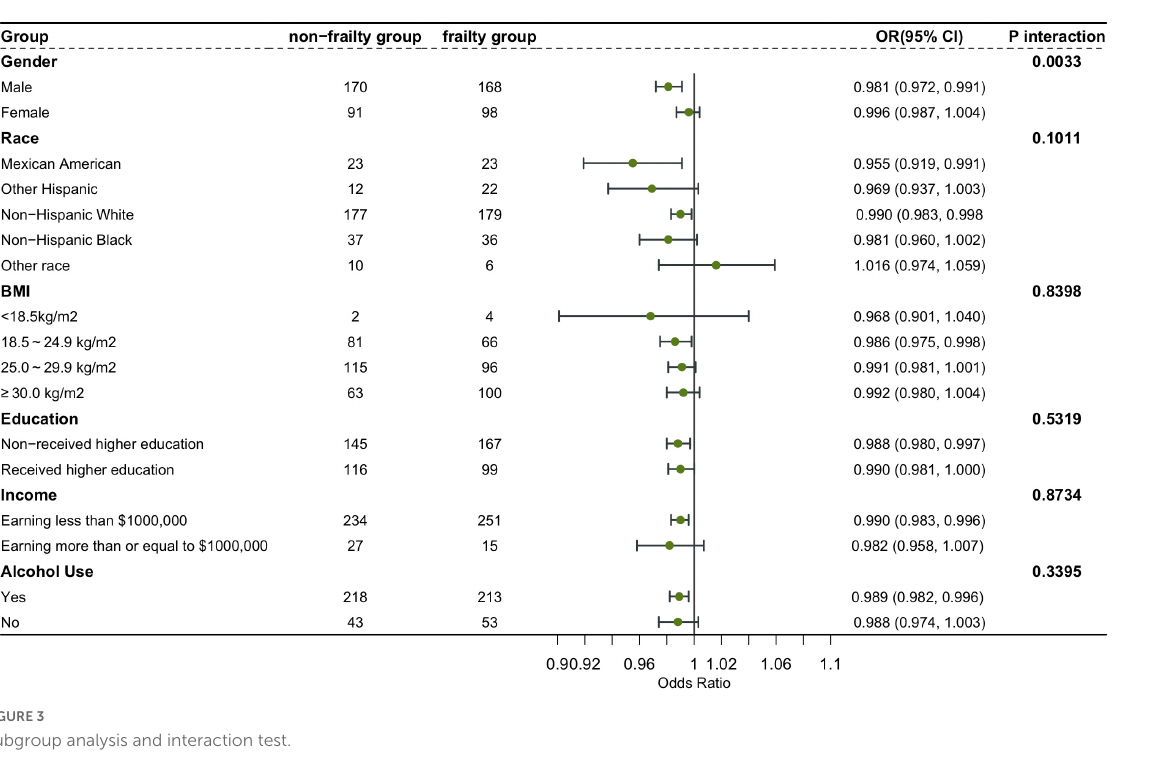
FIGURE3 Subgroup analysis and interaction